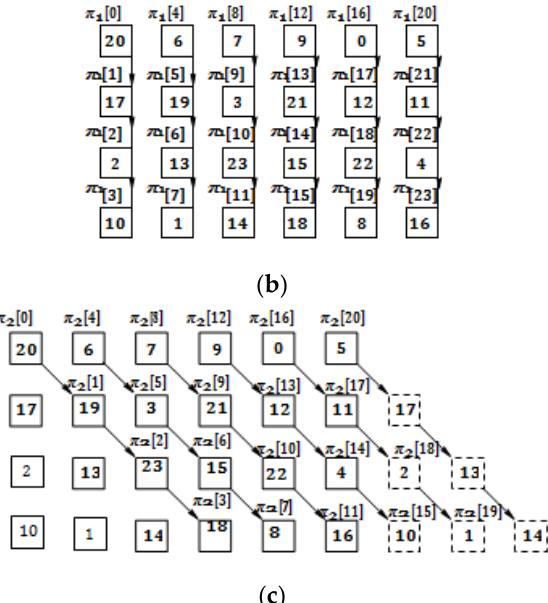
Figure 2. Generation of 4 × 6 helical interleavers. ( a ) Master interleaver written in matrix form, π = [20 , 6 , 7 , · · ·, 8 , 16]. ( b ) First helical interleaver written in matrix form, π 1 = [20 , 17 , 2 , …, 4 , 16]. ( c ) Second helical interleaver written in matrix form, π 2 = [20 , 19 , 23 , …, 13 , 14] [28,29].